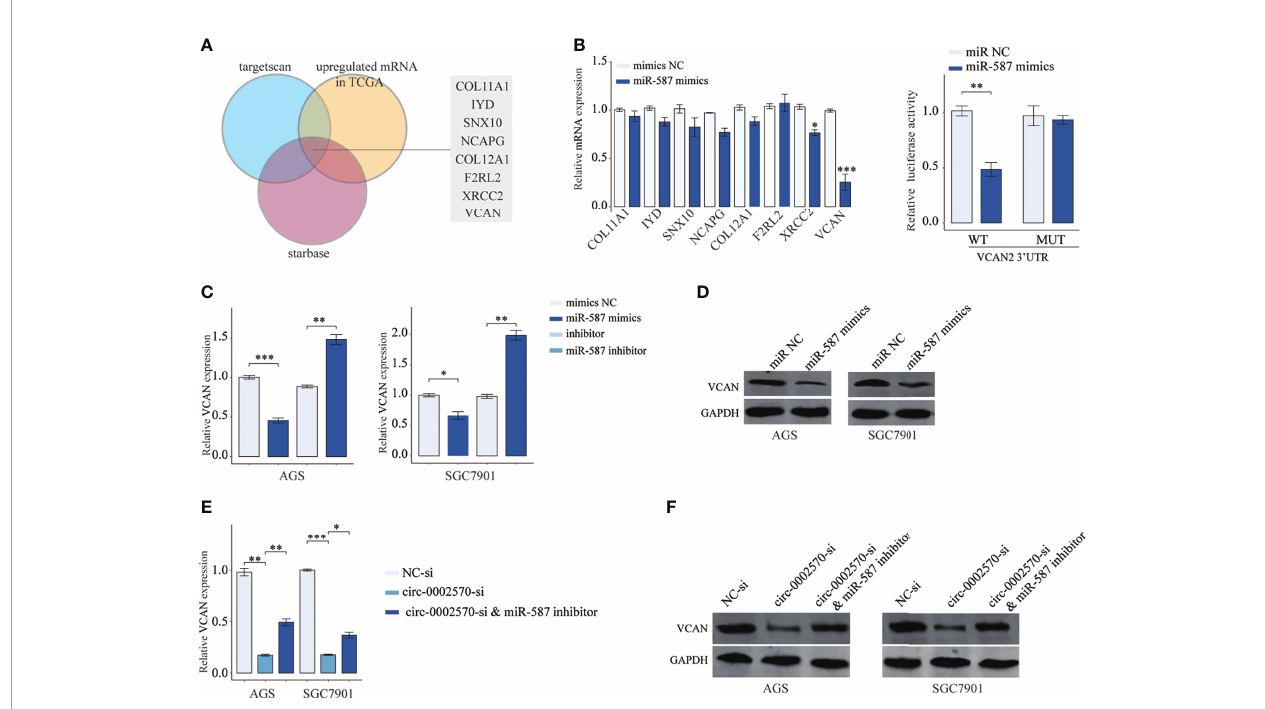
FIGURE 6 | VCAN is a target of miR-587. (A) Potential miRNA binding to circ-0002570. mRNA – miR-587 interaction was predicted by miRanda and targetscan. (B) RT-PCR for the levels of the potential candidates in AGS cells after miR-587 overexpression. Luciferase reporter assay con fi rmed the molecular binding. (C, D) The expression of VCAN at mRNA and protein in AGS and SGC7901 cells after miR-587 dysregulation. (E, F) RT-PCR and Western blot determined the expression of VCAN at mRNA and protein in AGS and SGC7901 cells transfected with NC-sh, circ-0002570-sh, or circ-0002570-sh+miR-587 inhibitor. * p < 0.05, ** p < 0.01, *** p <